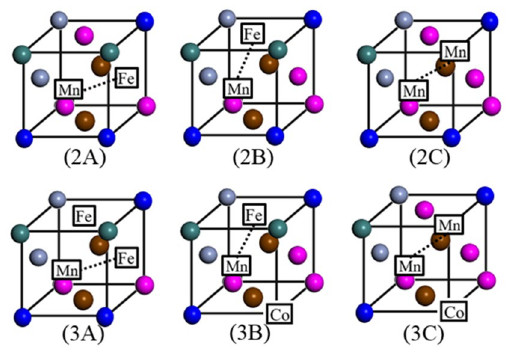
Figure 4. Configurations of the investigated di-vacancy (2A–2C) and tri-vacancy (3A–3C) clusters. The two elements enclosed within squares and connected by dotted lines in the figures (3A – 3C) each indicate the configuration of the di-vacancy cluster formed first, and the other element (also enclosed within a square) represents the third vacancy of the tri-vacancy cluster.